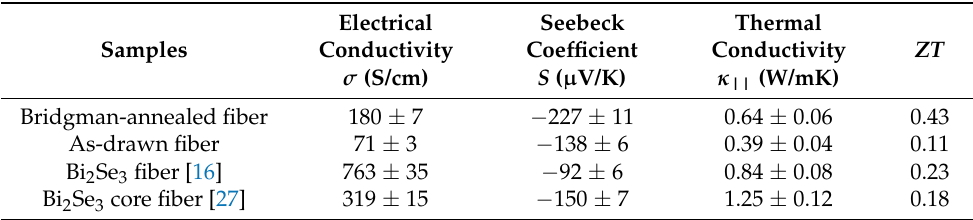
Table 1. Electrical conductivity, Seebeck coefficient, thermal conductivity, and ZT of the n-type Bi 2 Te 3 -based fibers at ~300